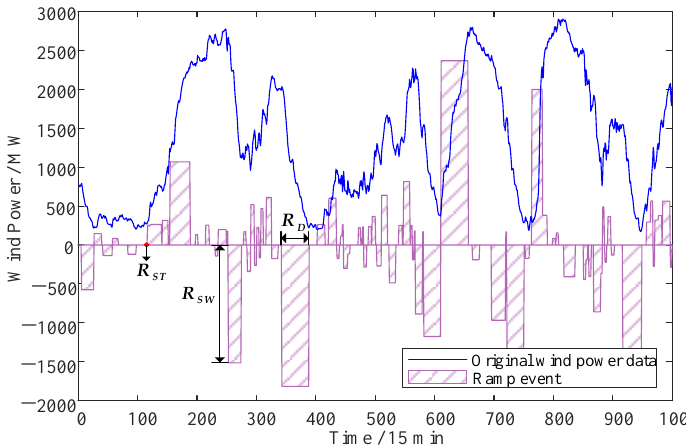
Figure 9. The effect graph of ramp features detected and extracted by OpSDA. Figure 9. The e ff ect graph of ramp features detected and extracted by